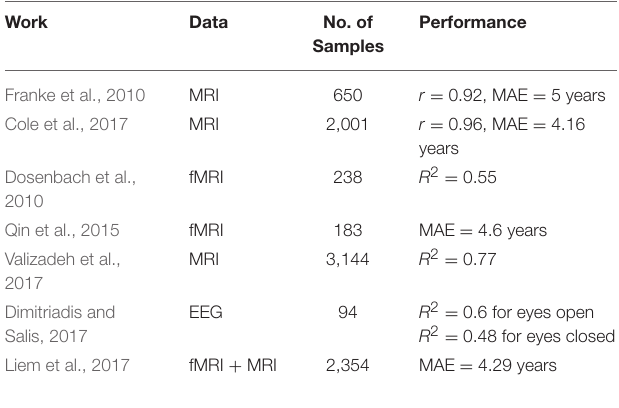
TABLE 1 | A summary of related work for predicting age from brain imaging